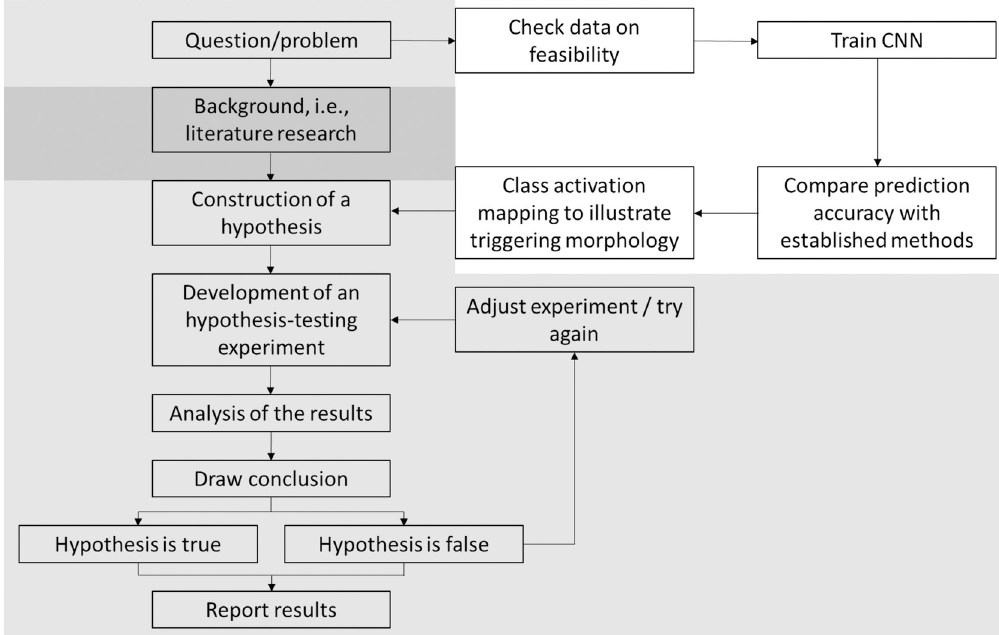
Fig 1. Comparison of the standard scientific method and the deep–learning based approach. Starting from a question/ problem to be solved, the standard scientific method is based on a thorough literature research resulting in the construction of a hypothesis. Conversely, the deep–learning based approach uses already available data to train a neural network to solve the defined task as good as possible. Assessment of its performance requires comparison with previously established methods. The best performing networks are then analyzed by class activation mapping to visualize the underlying morphology triggering the network. Based on these visualizations, a hypothesis is constructed and tested in an appropriate experiment. Light–grey: shared processes; dark–grey: standard scientific method; white: deep–learning based, hypothesis–generating